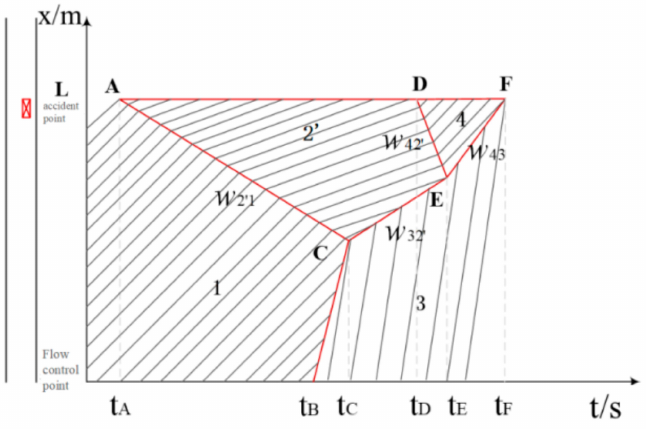
Figure 12. Diagram of vehicle time–space running